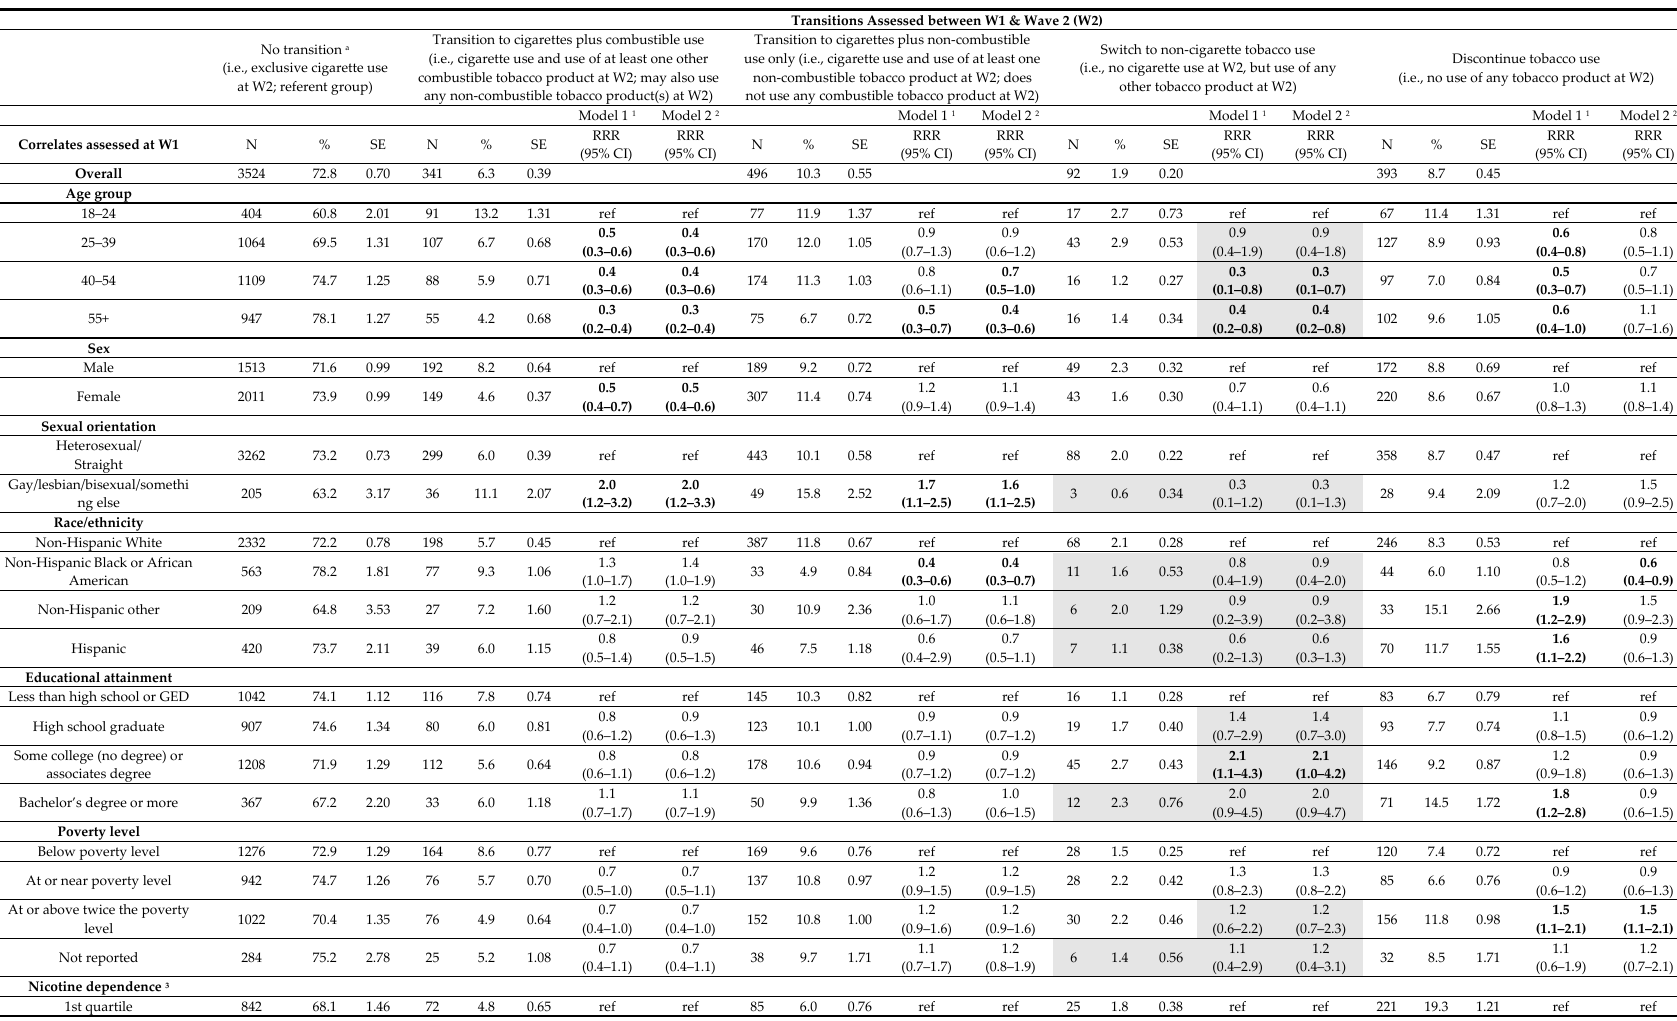
Table 3. Correlates of transitions in tobacco product use among ‘exclusive cigarette’ smokers at Wave 1 (W1); transitions defined with respect to all tobacco products ⱡ.